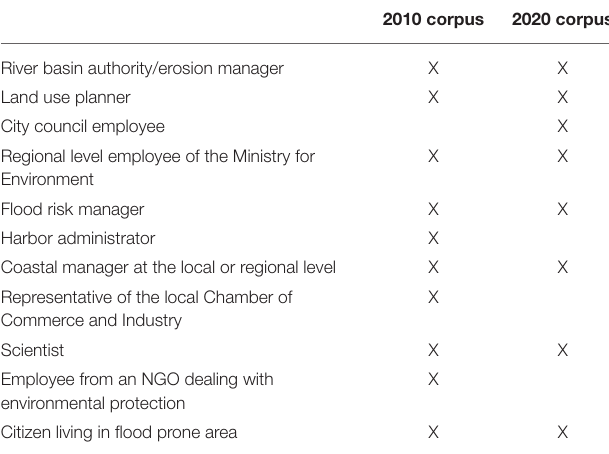
TABLE 1 | Categories of